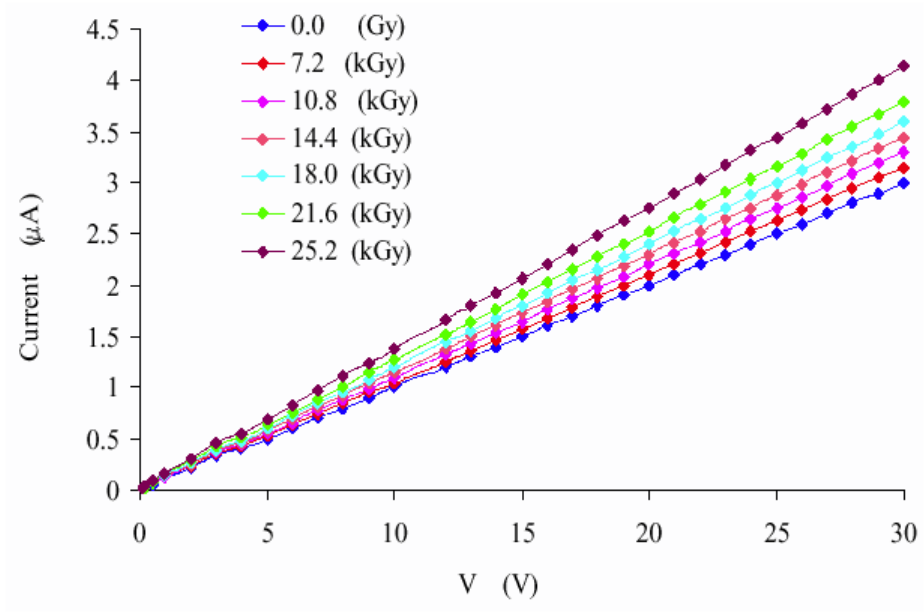
Figure 6. The I-V characteristics curves display a linear relationship indicting bulk-limited conduction mechanism for the as-printed and irradiated thick